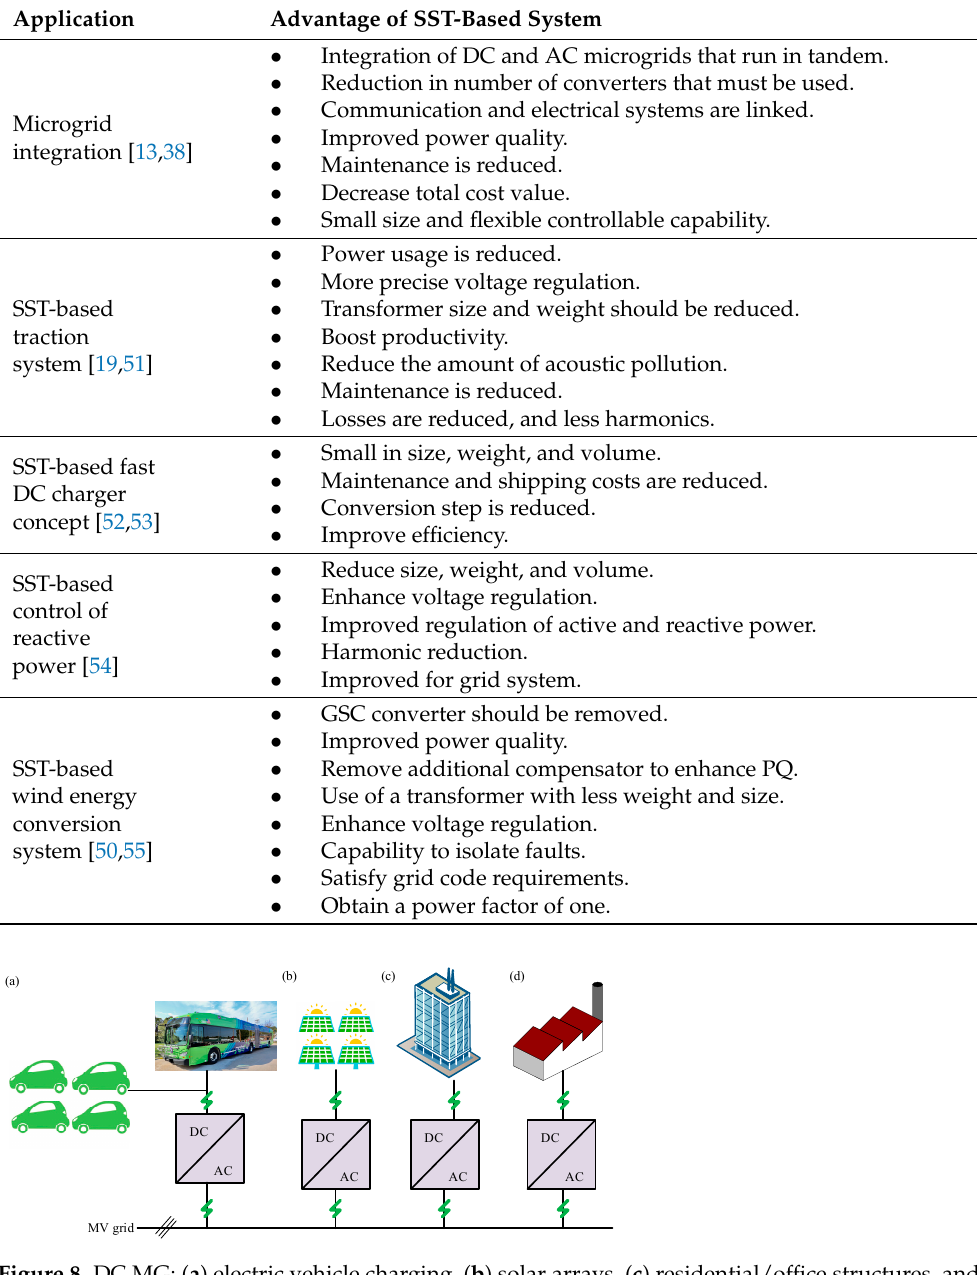
Table 3. Summary of SST Applications and Advantages in Future Intelligent Electrical Power System.